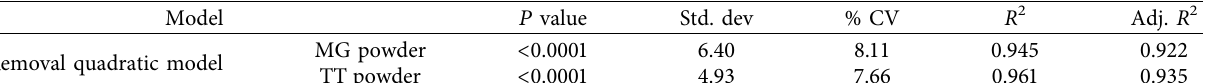
Table 3: Statistical results of the selected models using RSM for adsorbents.